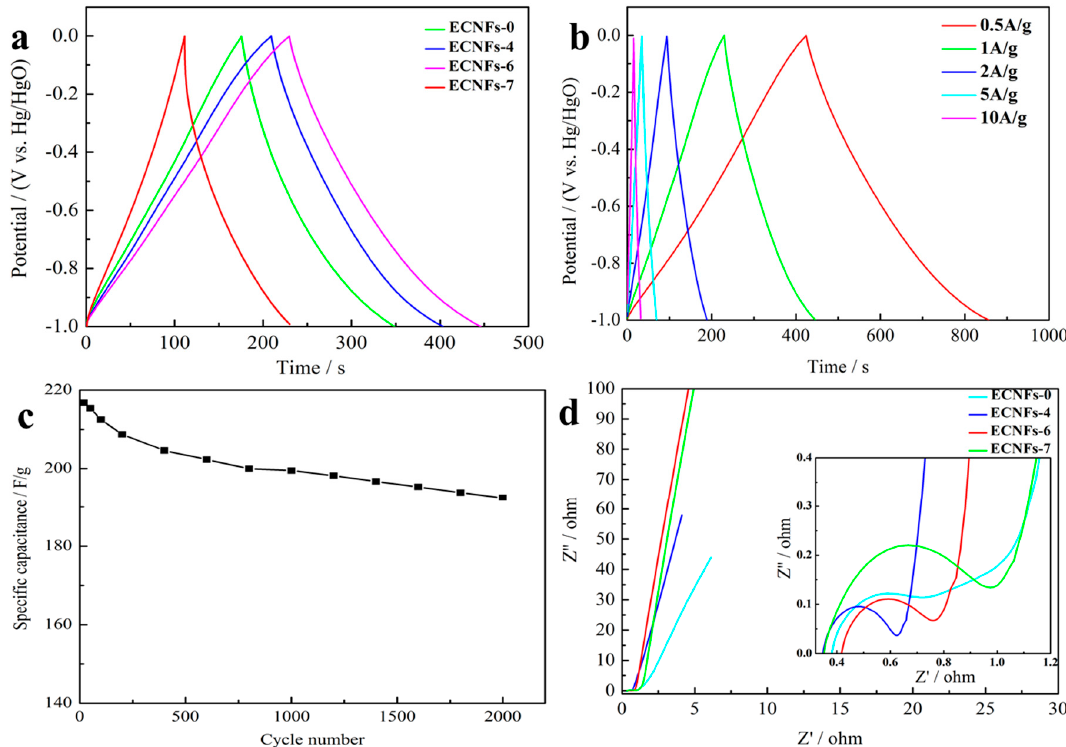
Figure 7. ( a ) GCD curves at 1 A/g; ( b ) GCD curves of ECNFs-6 at different current density; ( c ) Cycling performance ECNFs-6 at acurrent density of 1 A/g; and ( d ) Nyquist plots of ECNFs-based electrode with the high-frequency region and equivalent circuit diagram given in the inset.